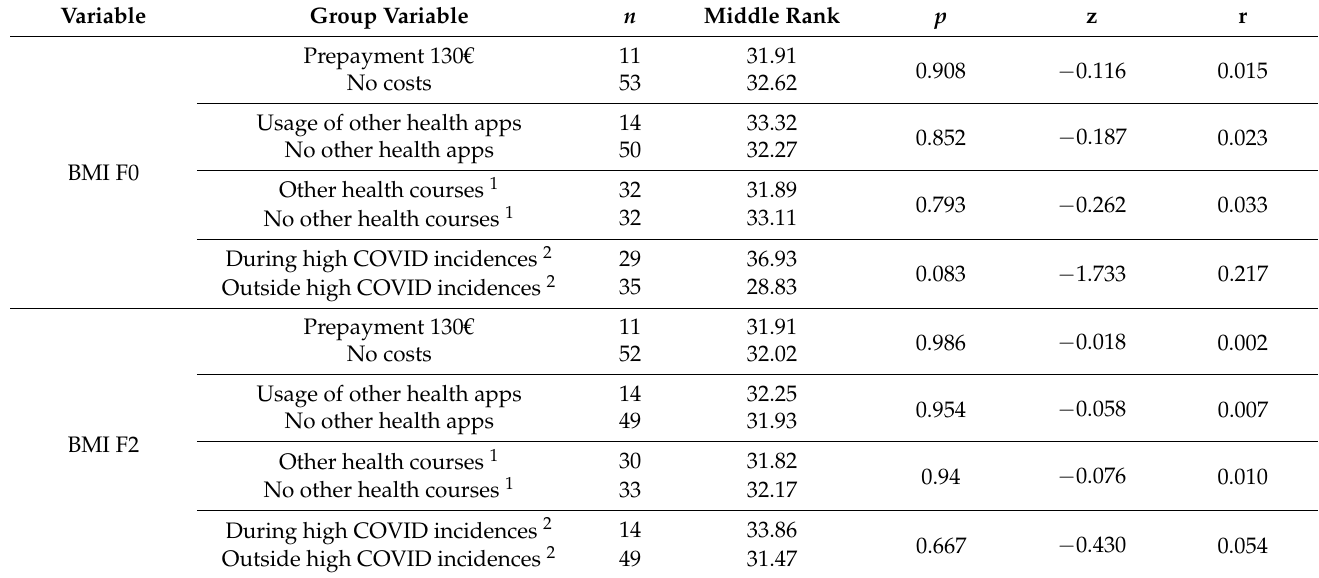
Table A12. Mann-Whiney-U test: Influence of different factors on the effect of the app on the BMI at the different measurement